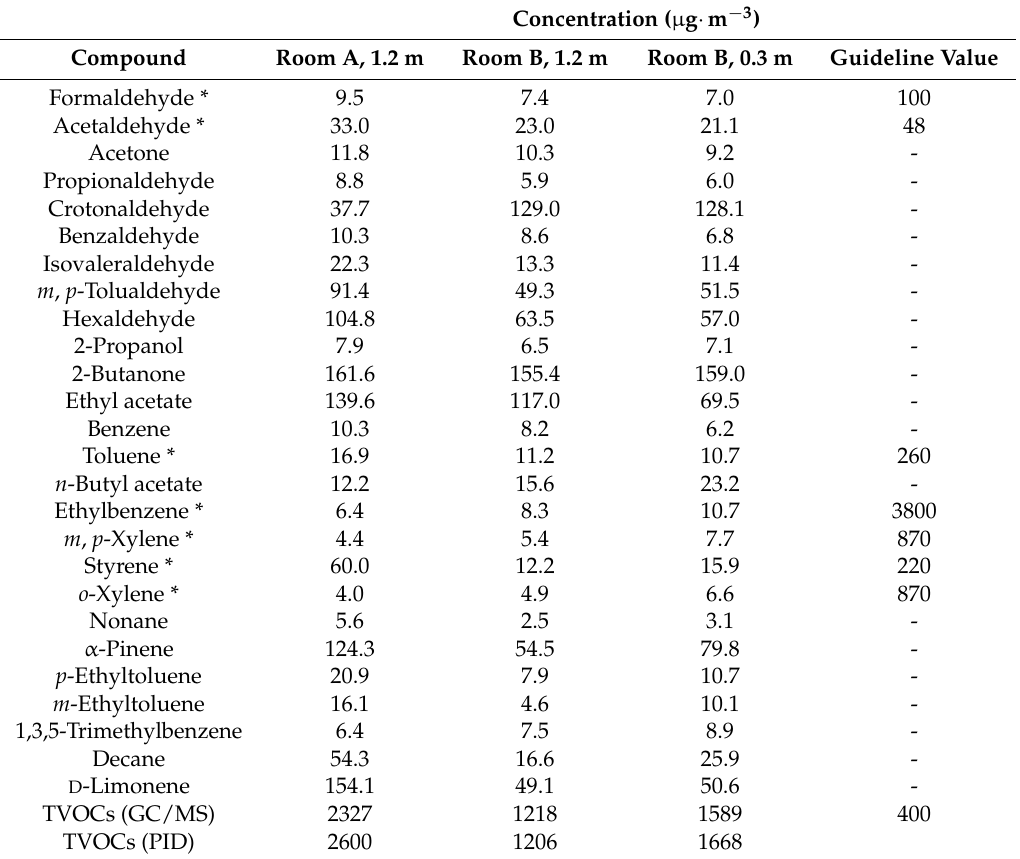
* Target compound listed in Table